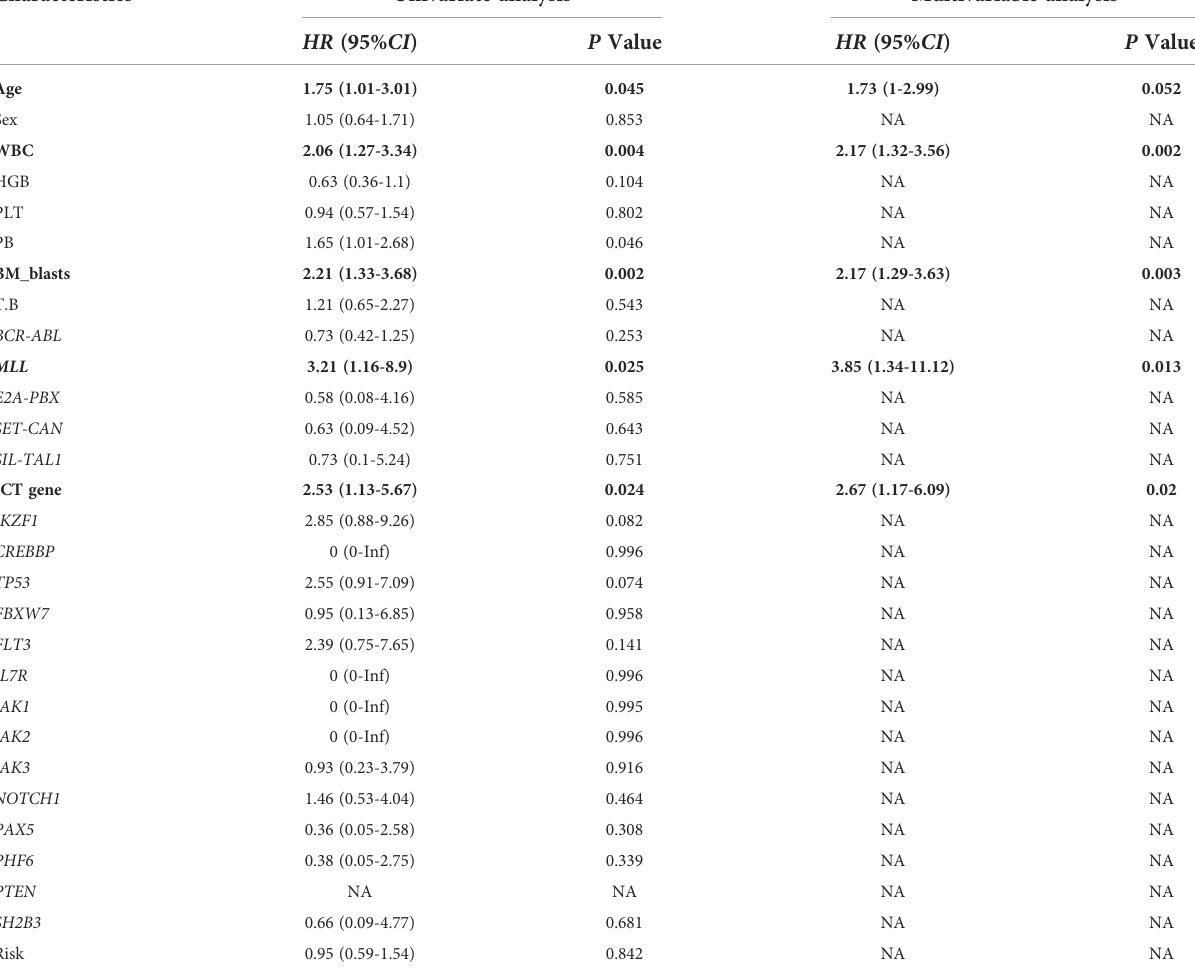
TABLE 2 Univariate and multivariate analysis.